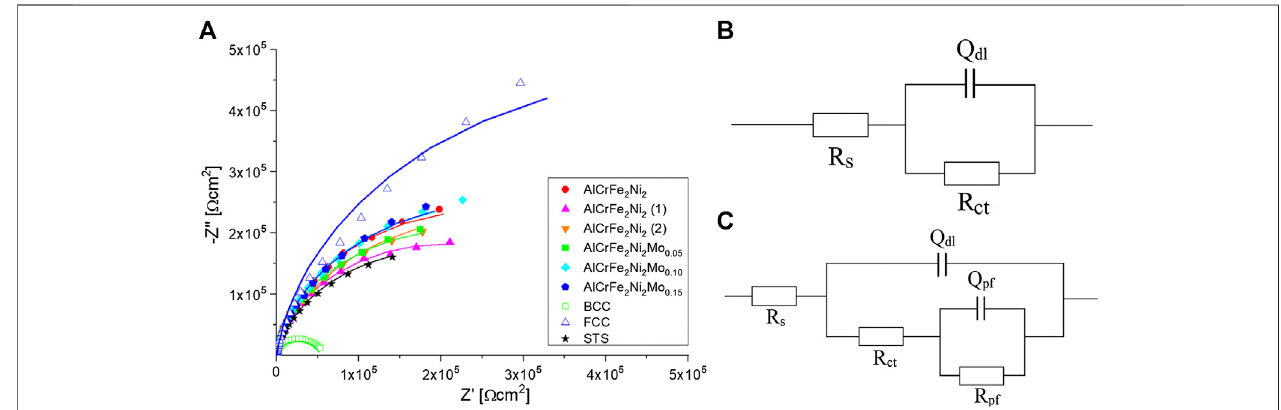
FIGURE 8 | Nyquist plot (A) and fi tted equivalent electrochemical circuits for all high entropy alloys (B) , and STS (C) .